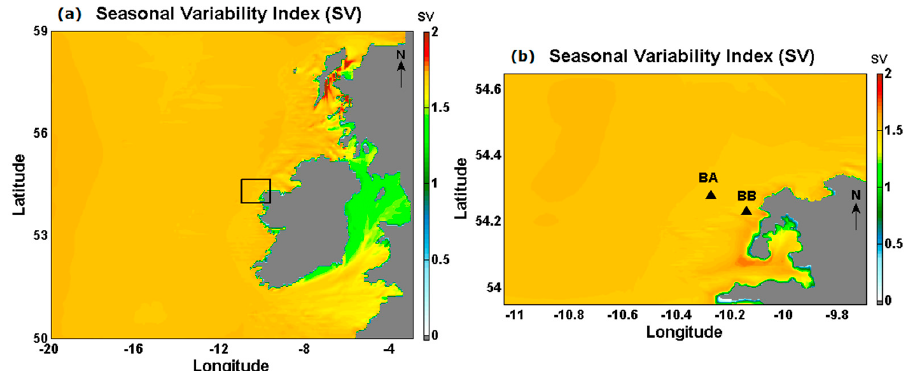
Figure 26. 12-year seasonal variability index ( SV ) values for ( a ) CI and ( b ) AMETS model domains.